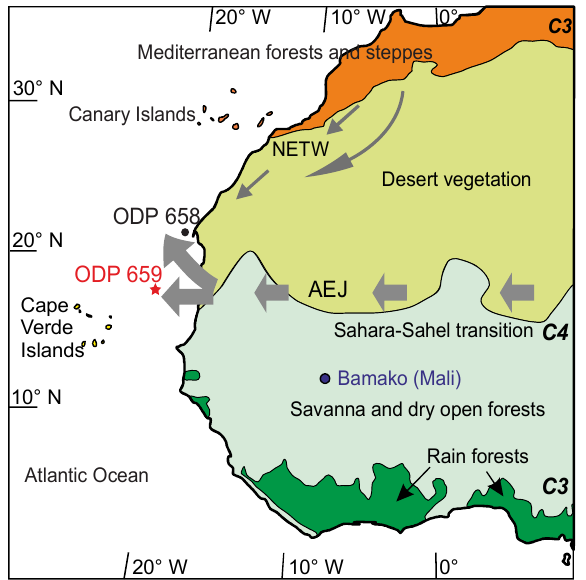
Figure 2. Location of Ocean Drilling Program (ODP) Sites 659 (star; 18 ◦ 05 (cid:48) N, 21 ◦ 02 (cid:48) W; 3070m water depth) and 658 (dot; 20 ◦ 45 (cid:48) N, 18 ◦ 35 (cid:48) W; 2263m water depth) offshore of West Africa (Ruddiman et al., 1987) and the location of Bamako in Mali. Main vegetation zones (dashed lines; simplified after White, 1983), dom- inant photosynthetic pathways (right), atmospheric trajectories (ar- rows). The thickness of the arrows marks the different altitudes of the African Easterly Jet (AEJ; > 3000m) and the north-east trade winds (NETW; <